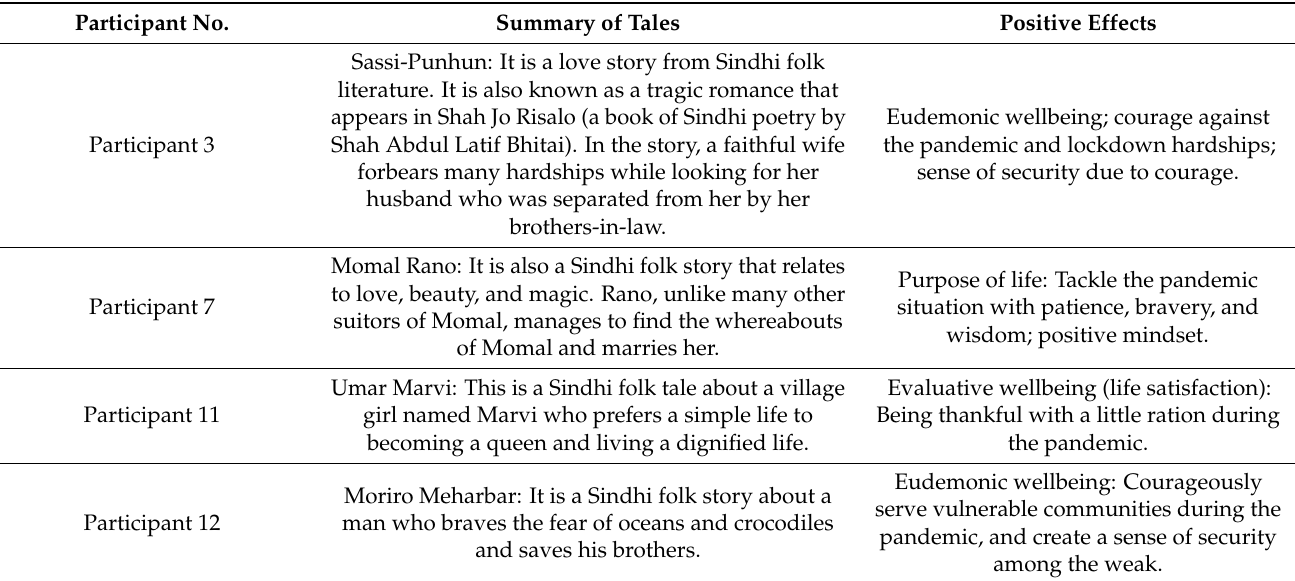
Table 3. The participants’ folk